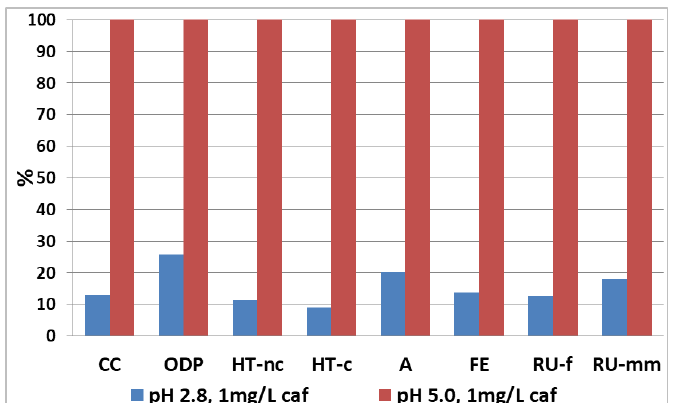
Figure 2. Comparison of the photo Fenton option for the degradation process of 1 m 3 of water per day (caffeine concentration of 1 mg/L). The values are reported grouped for impact category and as a percentage, assigning 100% to the highest impact for each category analyzed.